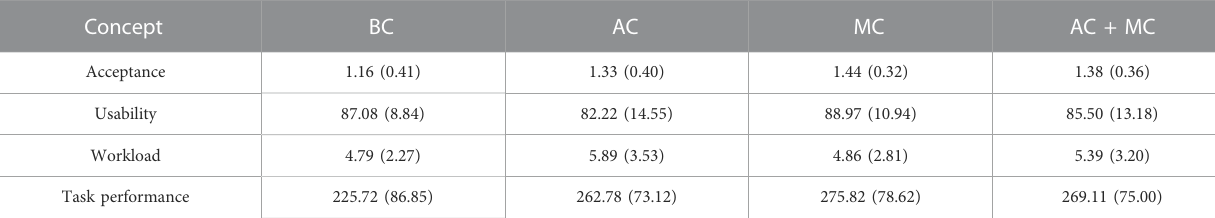
TABLE 2 Descriptive statistics M ( SD